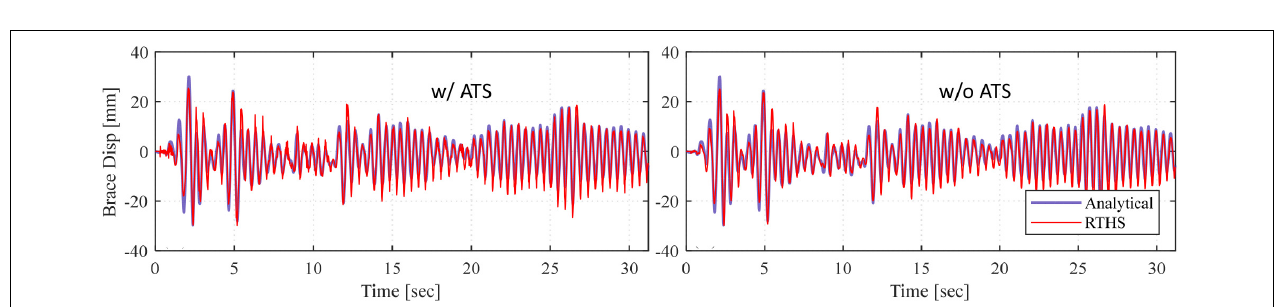
FIGURE 21 | Computational time for RTHS tests with Model 2 located at (A) local PC and (B) cluster.